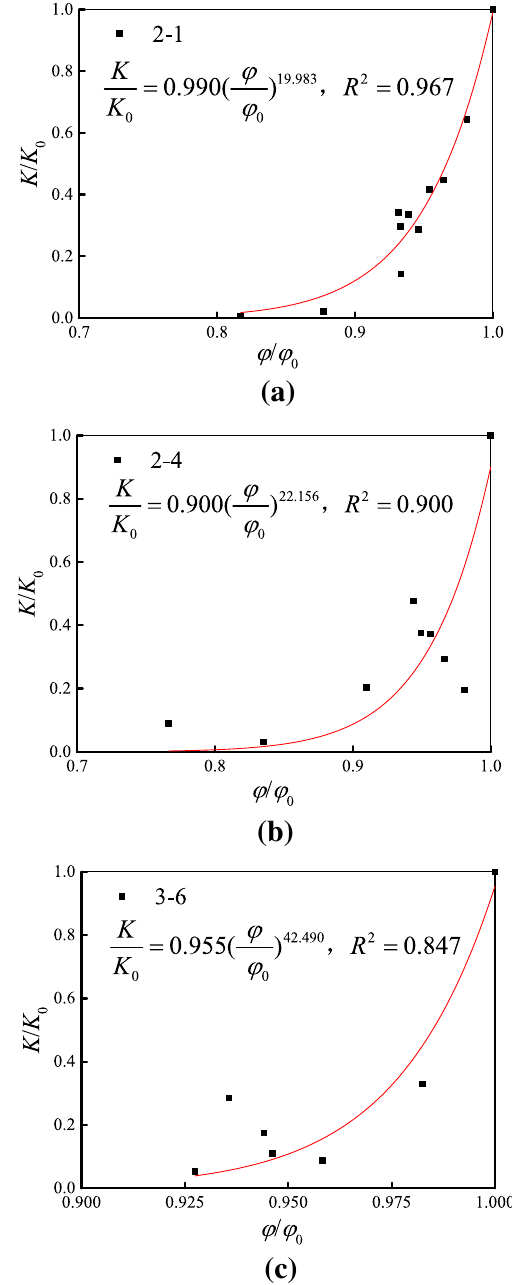
Fig. 12 Fitting relationship of permeability and porosity: a